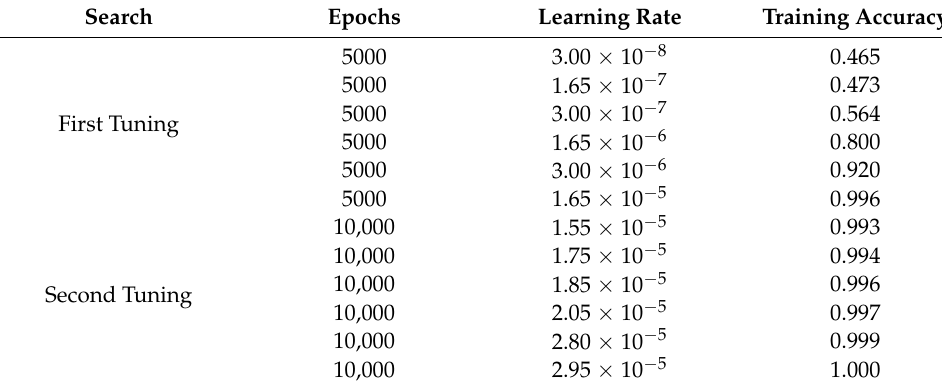
Table 2. Search of learning rate and accuracy score for training data.